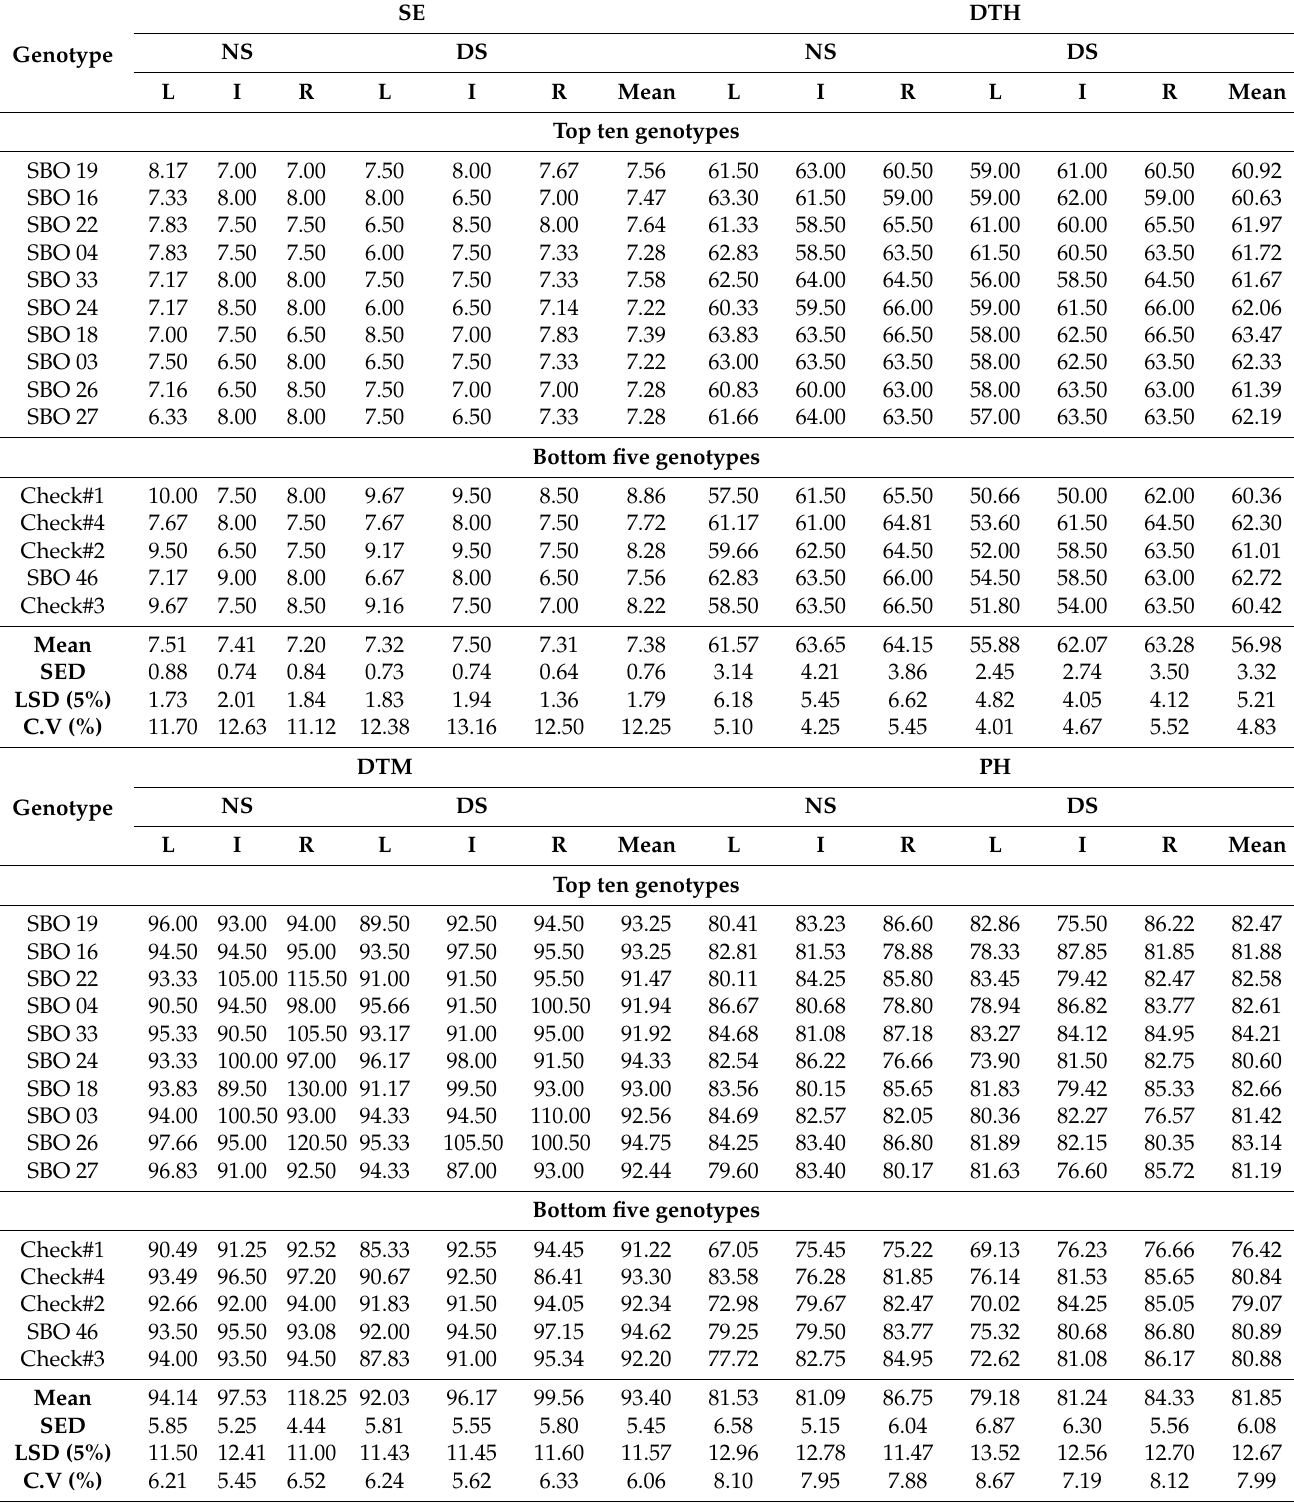
Table 5. Mean values for 12 agronomic traits of the top 10 and bottom 5 yielding genotypes selected after evaluation of 50 wheat genotypes under drought stress (DS) and non-stressed (NS) conditions and three nitrogen levels using two